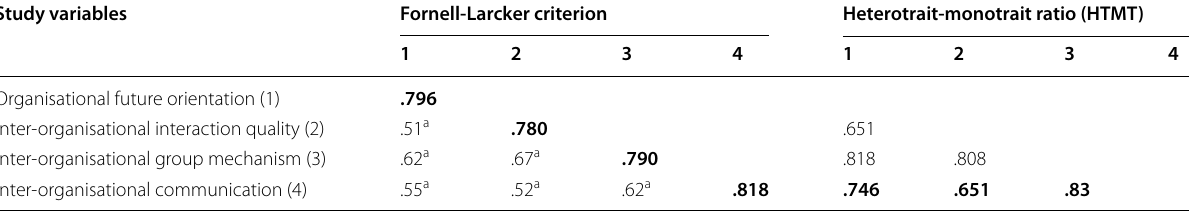
a Correlation is significant at the 0.01 level (2-tailed)